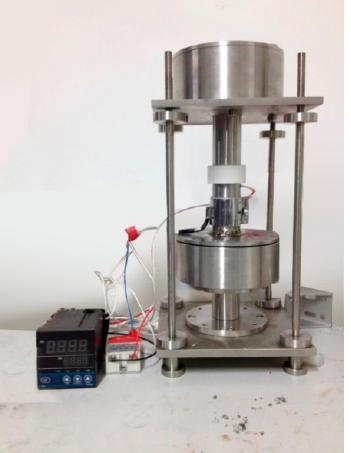
Figure 1. The freeze-casting device.